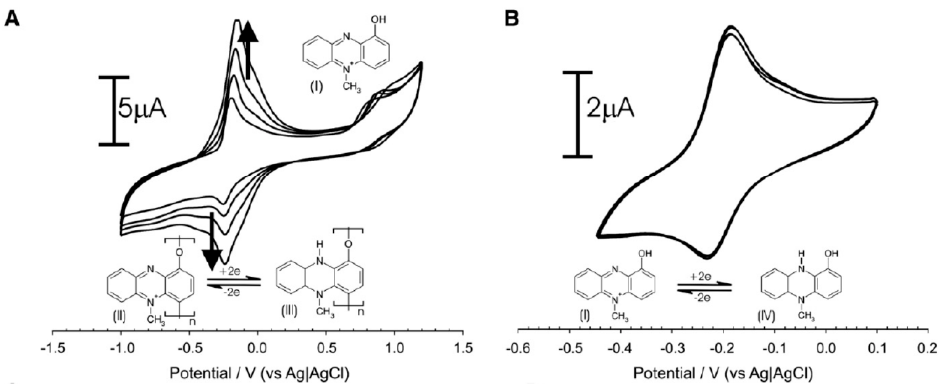
Figure 2. ( A ) Pyocyanin can undergo a reversible redox-reaction involving two electrons and an irreversible phenolic oxidation. ( B ) The phenolic oxidation and polymerization can be excluded by limiting the potential window. Adapted from Sharp et al. 2010 [9].